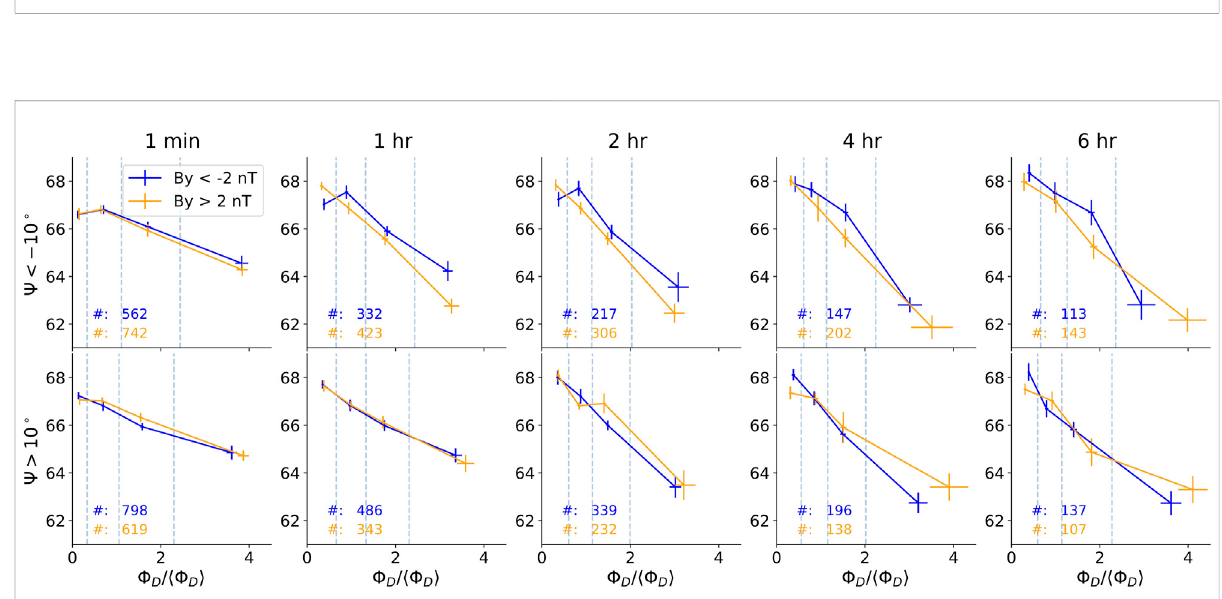
FIGURE 3 Median onset latitude from IMAGE + Polar onset lists. Top row: Negative dipole tilt. Bottom row: Positive dipole tilt. The two lines indicate differentIMFB y regimes.ColumnsrepresentsizeofaveragingwindowappliedtoIMFB y and Φ D parameter. Φ D binsareindicatedwithverticaldashed lines. Total number of substorms in each IMF B y group satisfying the IMF stability criteria is also printed in each